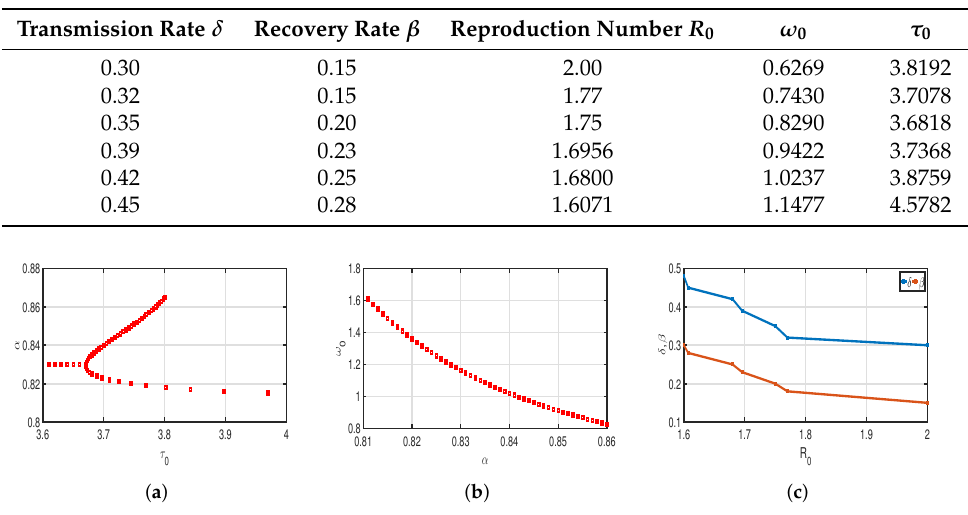
Table 2. Reproduction number R 0 and bifurcating point τ 0 .